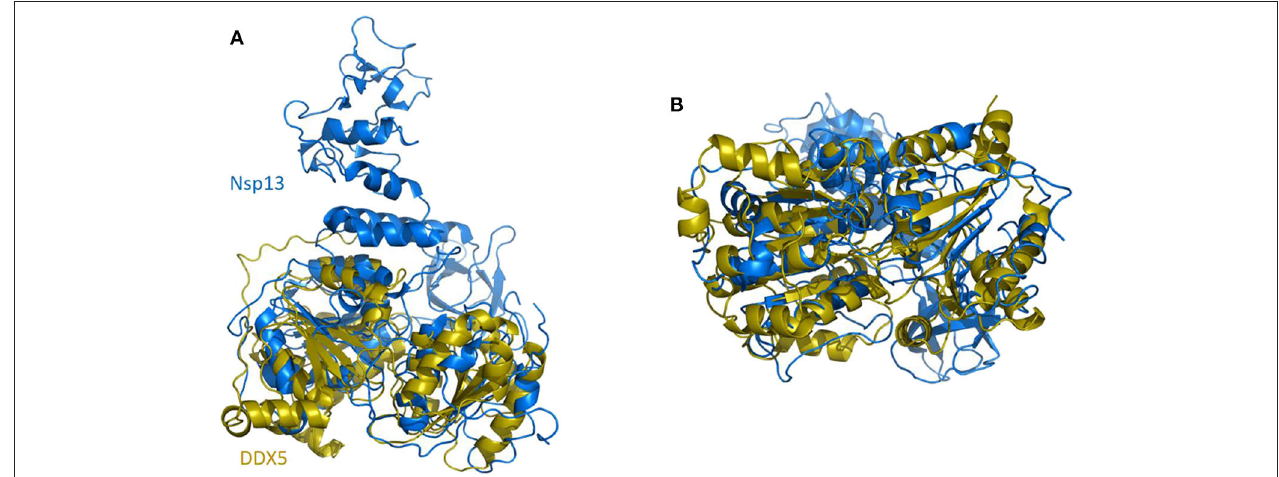
FIGURE 11 | Superposition of SARS-CoV-2 Nsp13 on DDX5 homology model. Cartoon representation of DALI superposed Nsp13 (blue) and the D1D2 core of DDX5 homology model (gold). (A) Side and (B) bottom